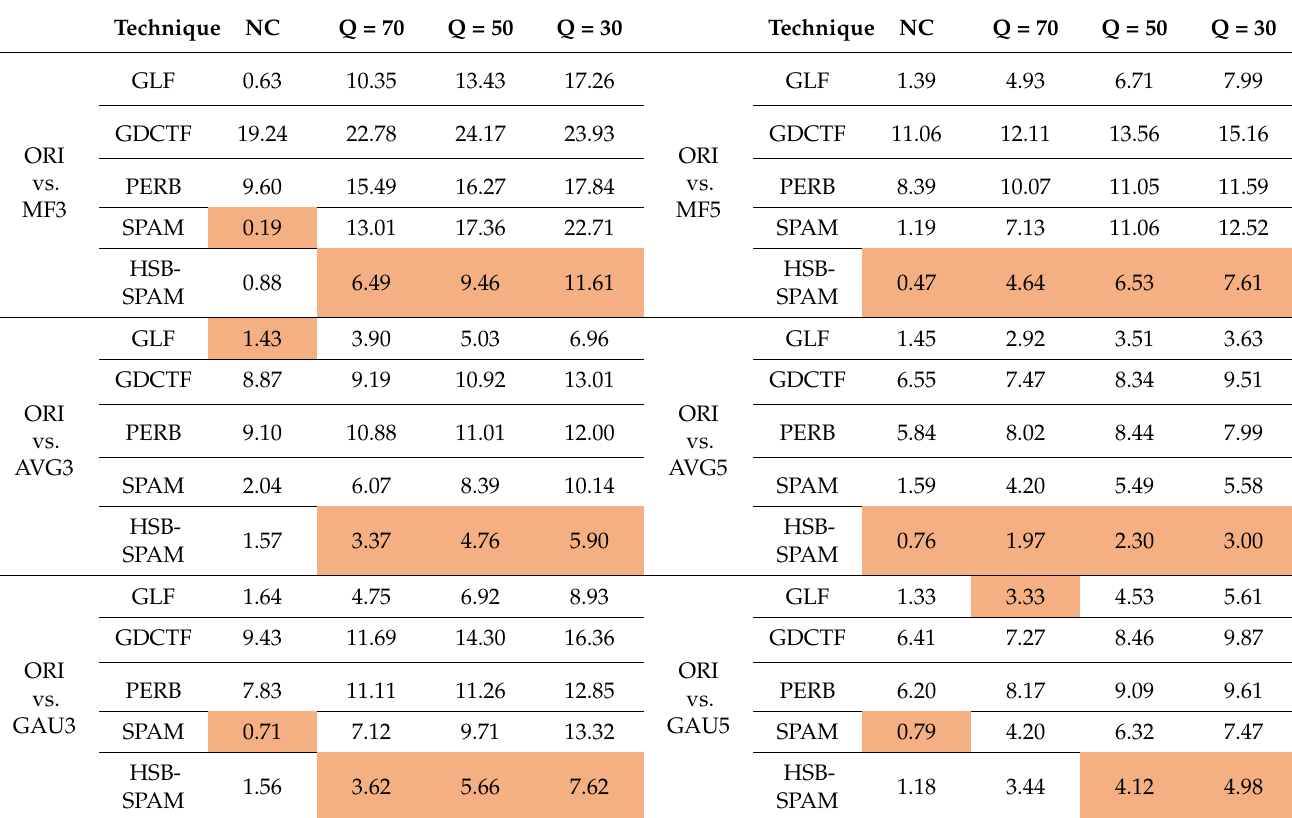
Table 4. Percentage of detection error on 64 × 64 filtered